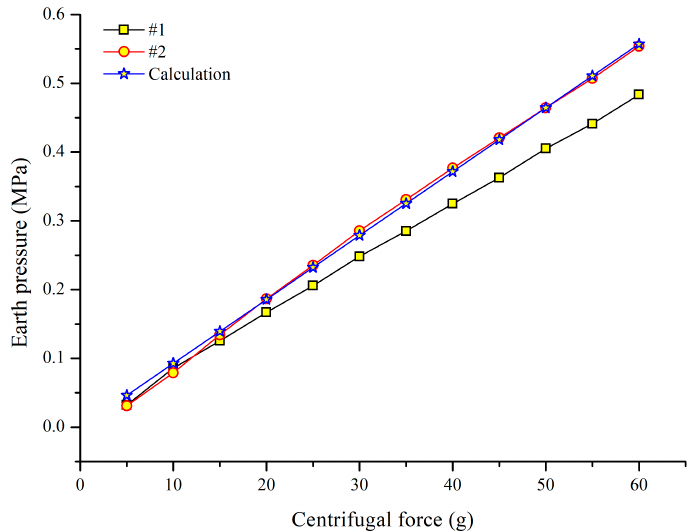
Figure 16. Comparison of the earth pressure obtained by FBG-based gauges and calculation.